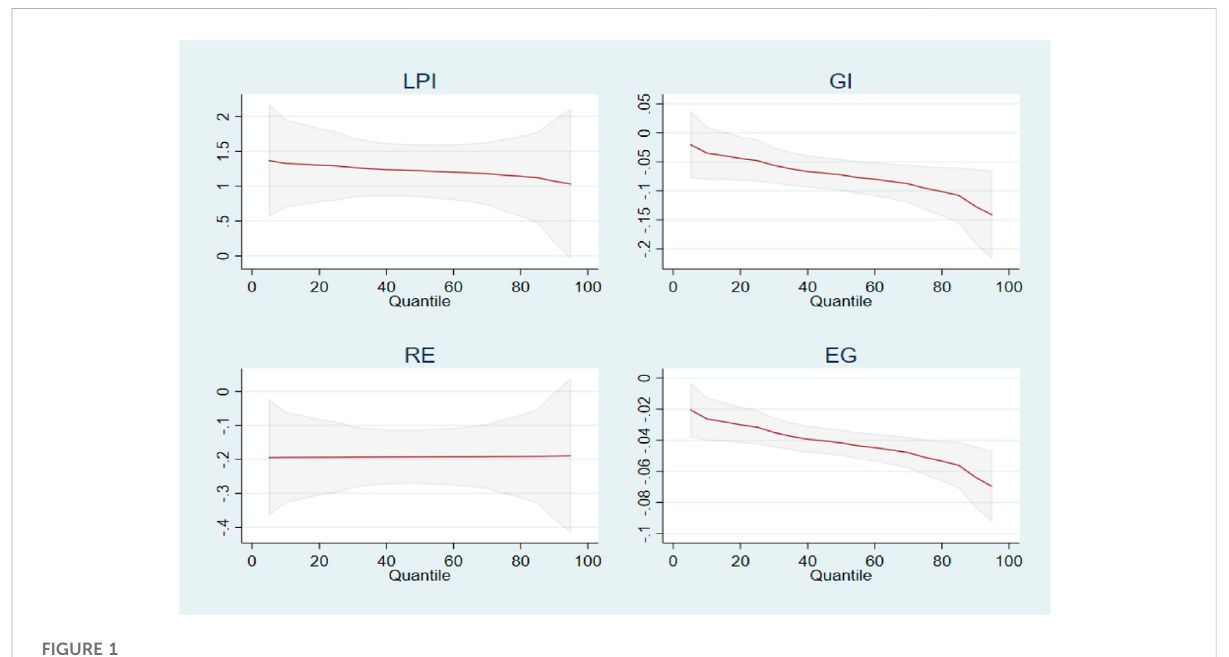
FIGURE 1 Quantile regression plot.